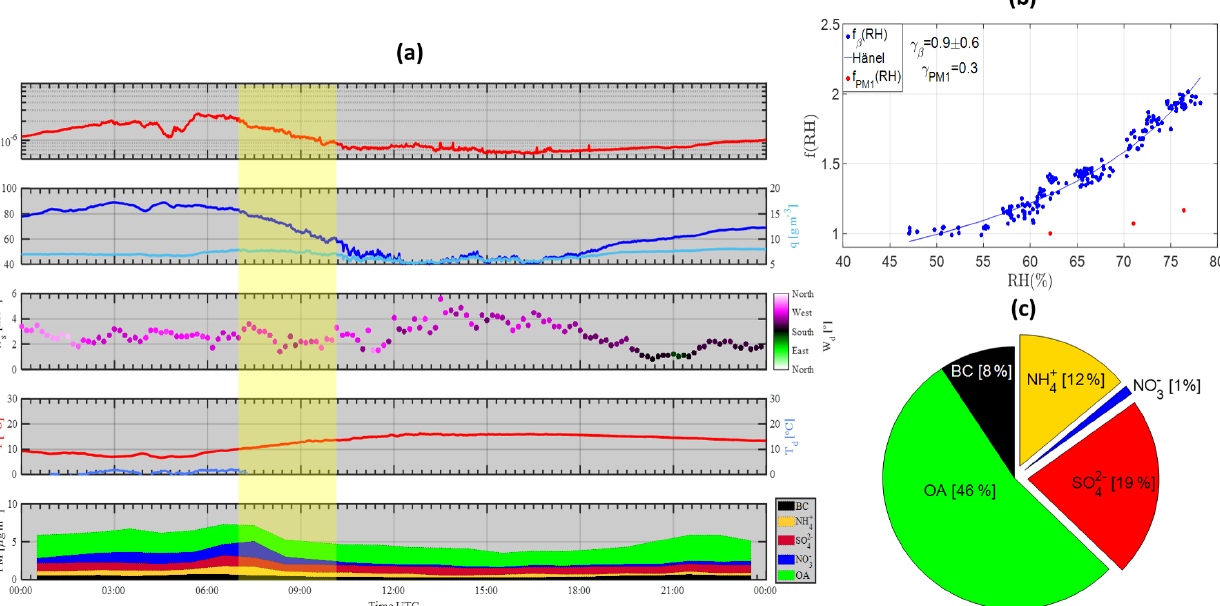
Figure 3. As noted in Fig. 2 but using case 8 on 17 May 2016 with the highlighted region from 07:40 to